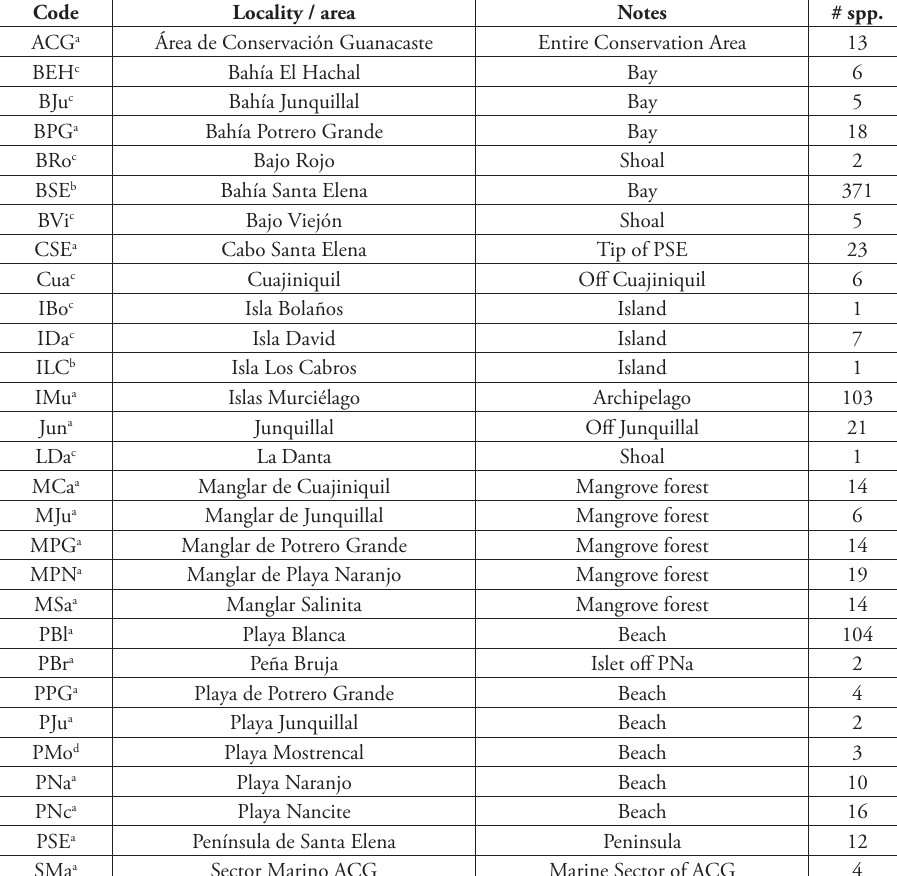
Table 2. Localities of the samples reported in the Appendix. # spp. = number of species reported from that site. a = Protected area, b = area in the process of being officially protected, c = marine area not pro- tected, and d = private reserve (protected